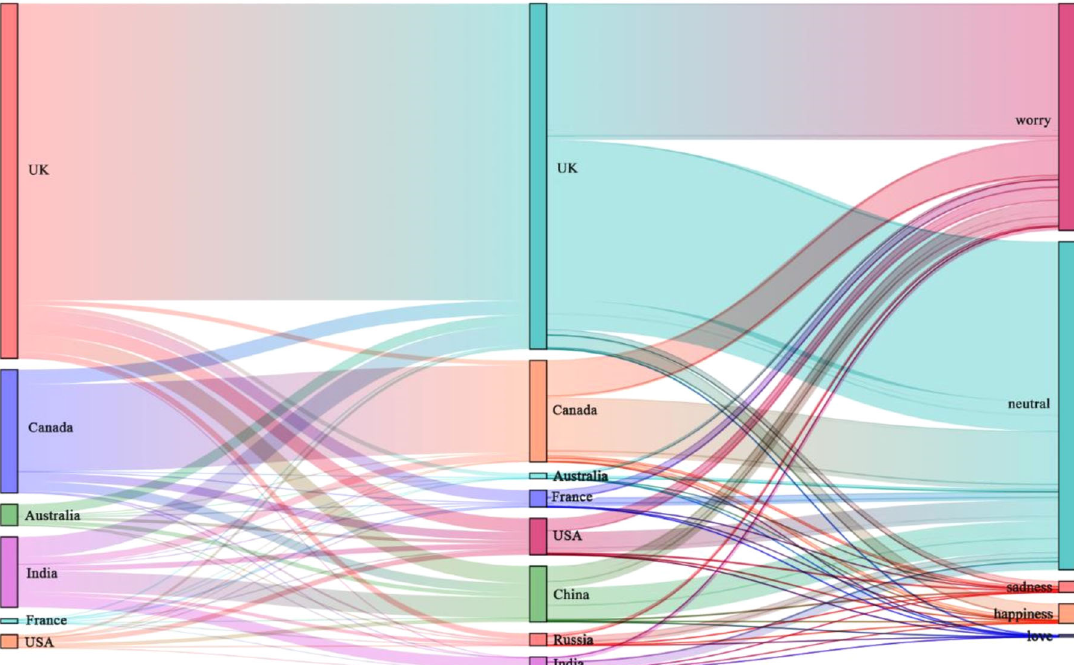
Fig. 4 Sankey diagram of the distributions of public emotions in six typical countries. The netizens of the USA, the UK, Canada, Australia, France and India ( left ) are mostly concerned about vaccine-related news beyond their own country ( middle ). The populations of Australia and India pay more attention to foreign countries than their own countries. As vaccine-producing countries, the permanent members of the United Nations Security Council are expected to shoulder more responsibility for ending the COVID-19 pandemic. The trajectories show the dynamic fl ows of emotional polarities across the countries ( right ) (see the sample size in the